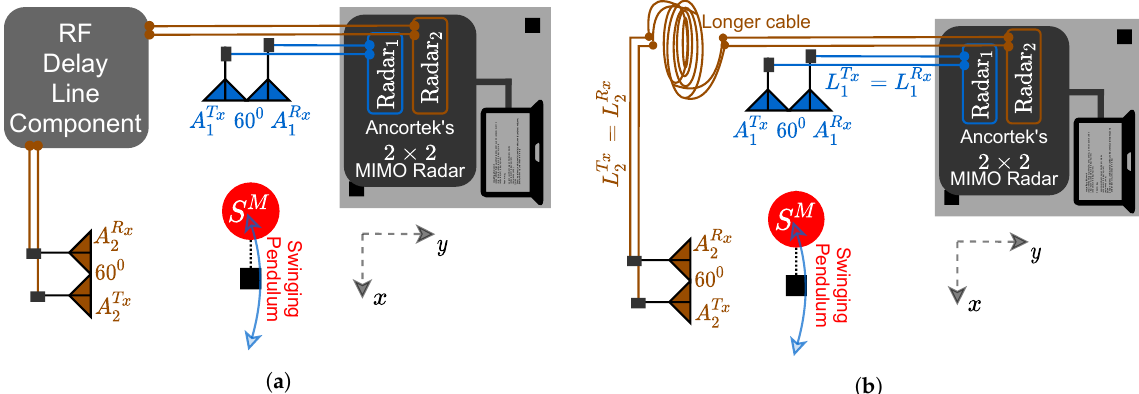
Figure 4. Setup to induce a fixed propagation delay by either using ( a ) an RF delay line component or ( b ) different cable ) (cid:54) = ( L T x ) lengths, i.e., ( L T x , L R x , L R x 2 2 1 1